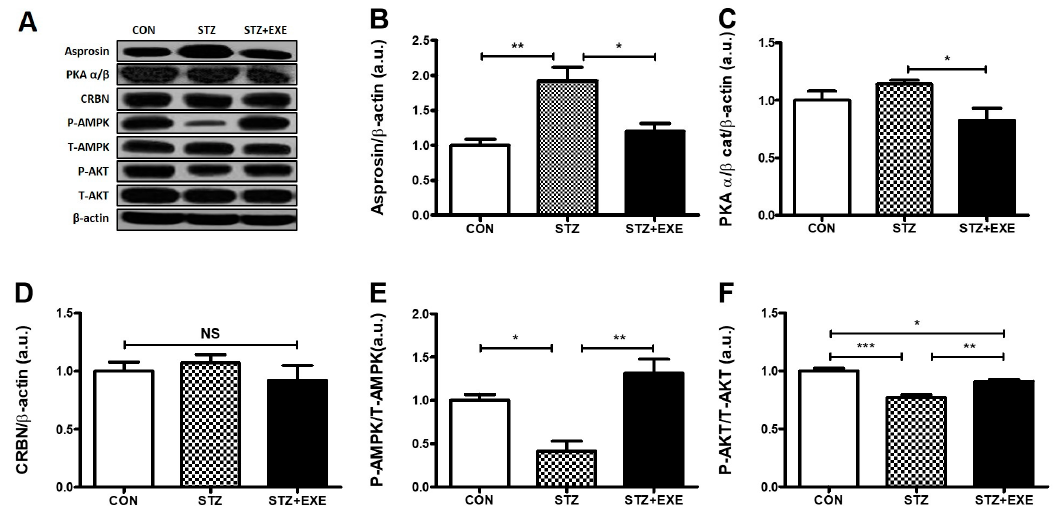
Figure 2. Aerobic exercise training decreased asprosin and PKA levels, but increased AMPK and Akt levels in the liver of type 1 diabetic rats. ( A ) Representative western blot, ( B ) Western blot analysis of liver asprosin levels in type 1 diabetic rats, ( C ) Western blot analysis of PKA levels in type 1 diabetic rats, ( D ) Western blot analysis of CRBN levels in type 1 diabetic rats, ( E ) Western blot analysis of AMPK levels in type 1 diabetic rats, ( F ) Western blot analysis of Akt levels in type 1 diabetic rats. Results are expressed as the mean ± standard error (SE); * p < 0.5, ** p < 0.05, and *** p < 0.001; NS, not significant.